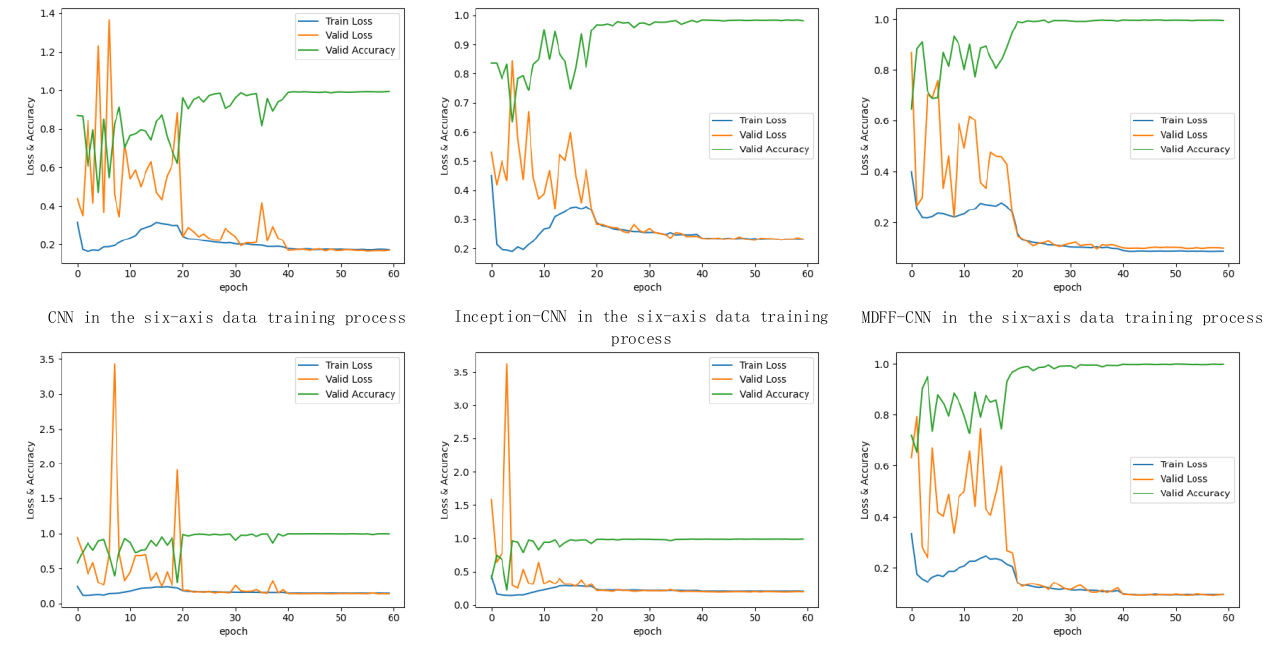
Figure 14. Loss value curve and accuracy curve during convolutional neural network model training.